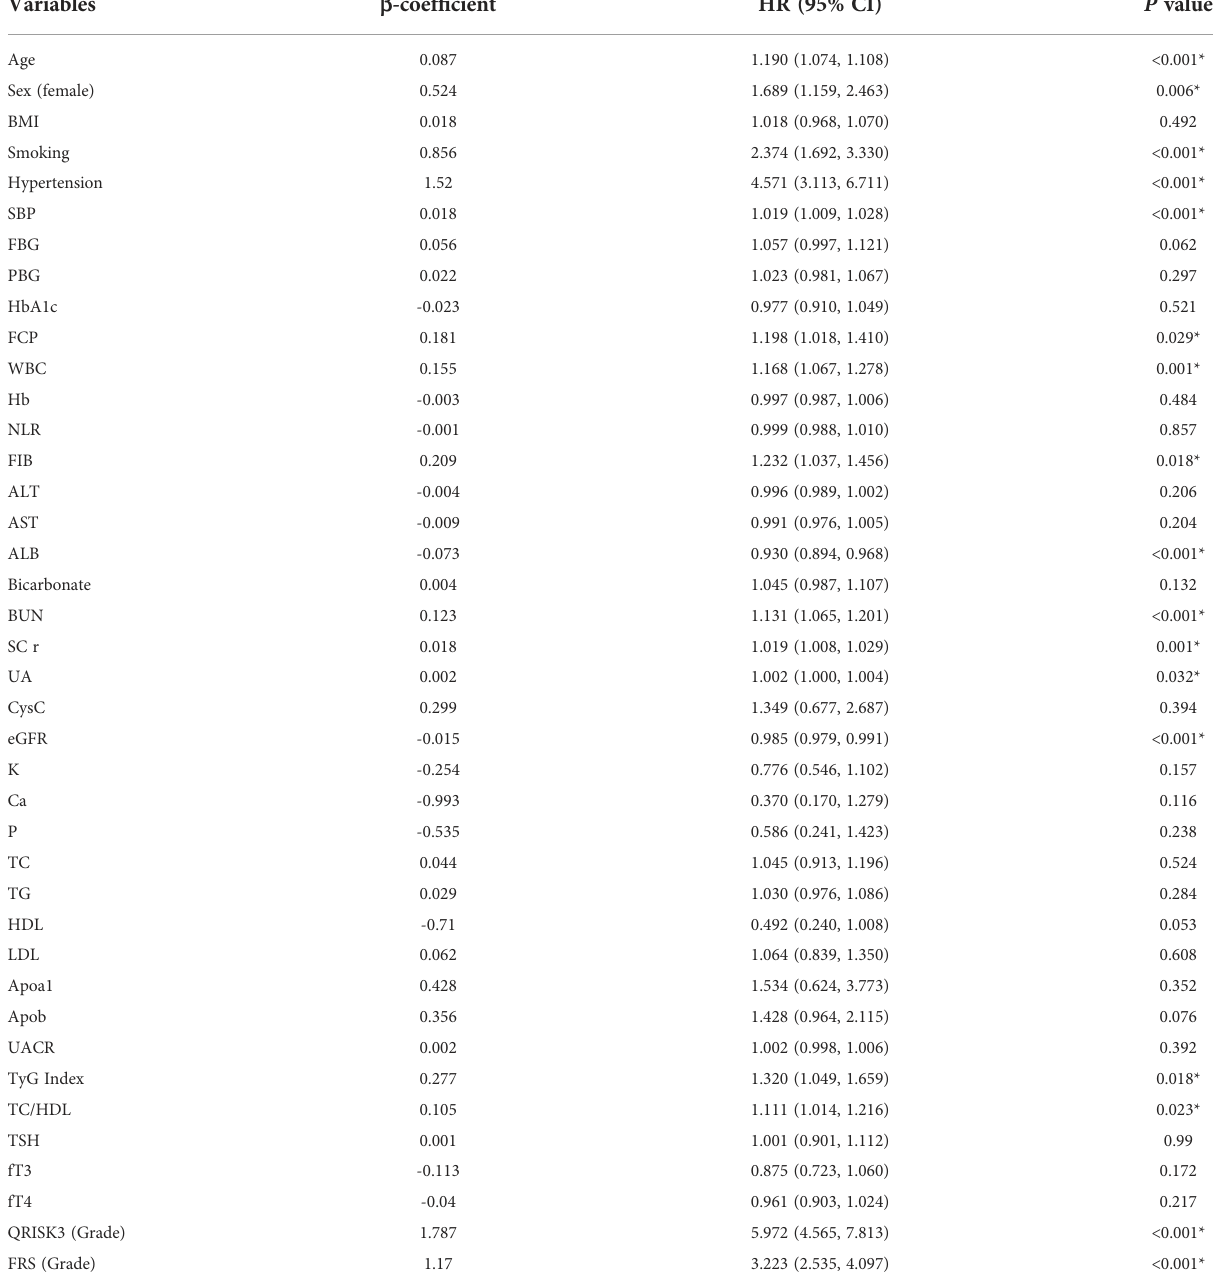
TABLE 2 Cox regression analysis of CVD- related risk factors.